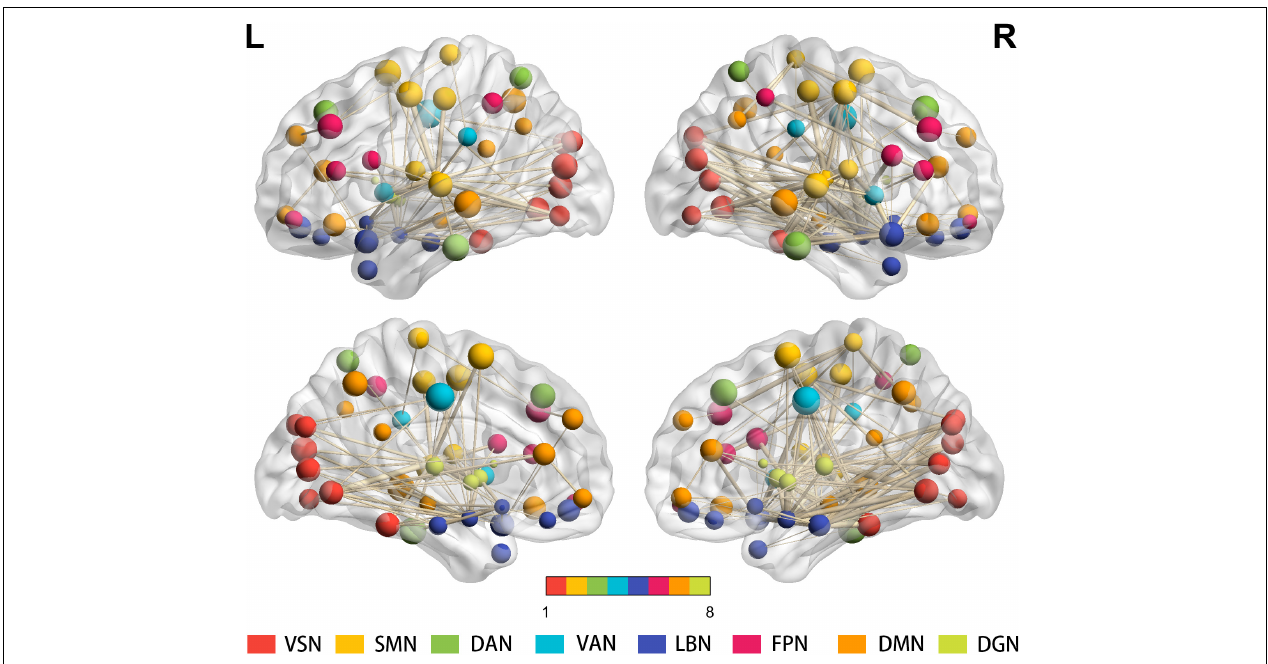
FIGURE 3 | Results for the total degree of connectivity between nodes at the edge level. Four hundred forty-three widely distributed connectivity pairs—mainly regarding the intra-network connectivity of 8 RSNs, and inter-network connectivity between the SMN, DGN, and other RSNs—are shown (all p < 0.05, FDR corrected). The same color of spheres represented ROIs were from the same RSNs. PD, Parkinson’s disease; HC, healthy control; ROIs, regions of interest; RSNs, resting-state network; VSN, visual network; SMN, somatomotor network; DAN, dorsal attention network; VAN, ventral attention network; LBN, limbic network; FPN, frontoparietal network; DMN, default mode network; DGN, deep gray matter network; FDR, false discovery